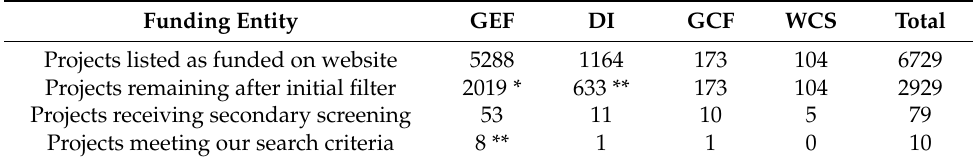
Table 4. Summary of the number of projects funded by Global Environment Facility (GEF), Dar- win Initiative (DI), Green Climate Fund (GCF), and the Wildlife Conservation Society’s Climate Adaptation Fund (WCS) as they went through our review process to identify projects that explicitly proposed to eradicate an invasive mammal from an island(s) and stated part of the reasoning behind requesting funding was to improve resilience to the impacts of climate